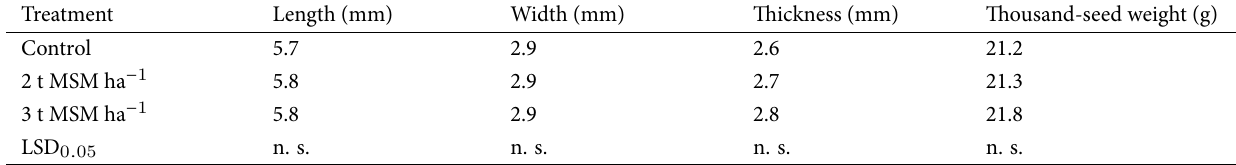
Table 4 Effect of mustard seed meal on borage mericarp length, width, thickness, and 1,000-seed weight. Treatment